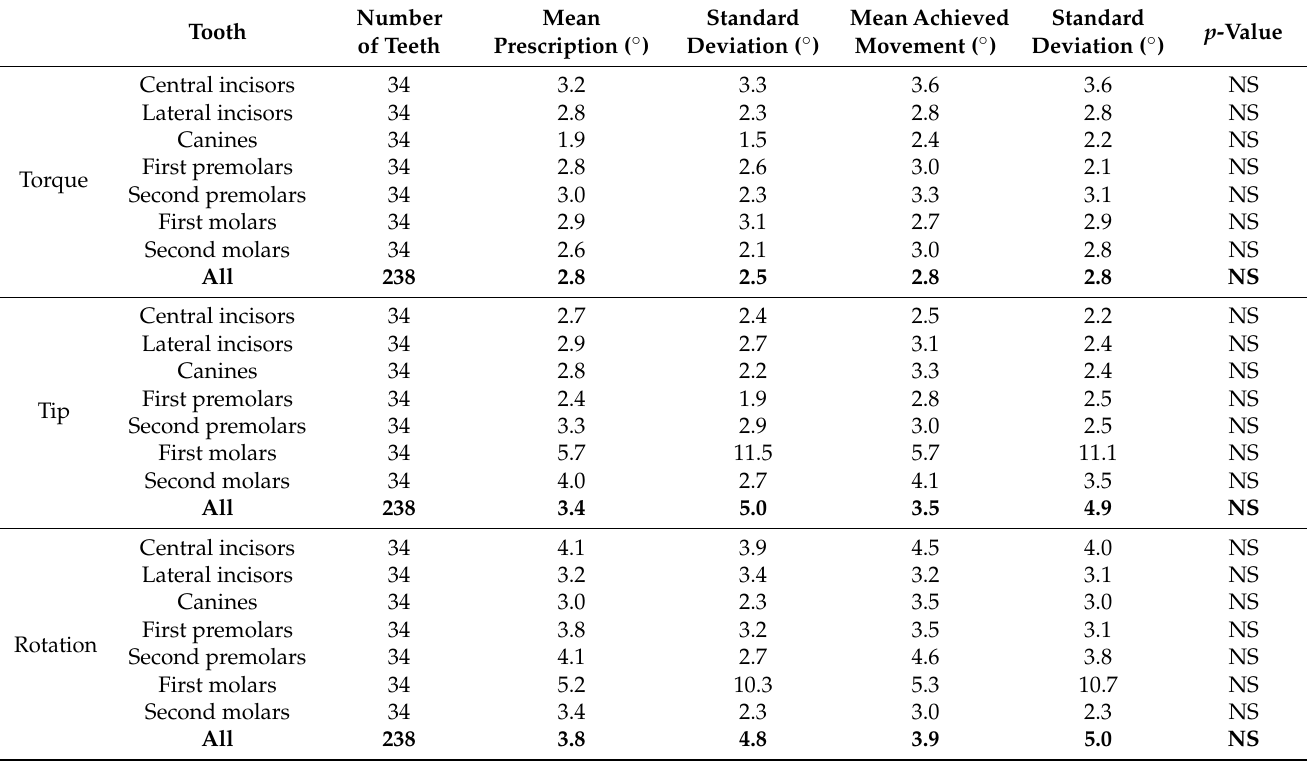
Table 2. Descriptive statistics for Prescription Achieved